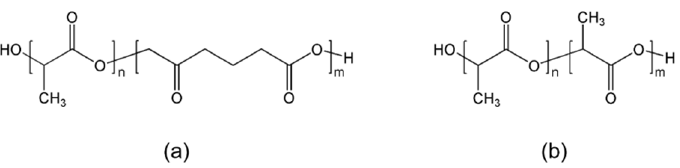
Figure 1. Chemical structure of polymer ( a ) PLCL and ( b ) PLDLA.